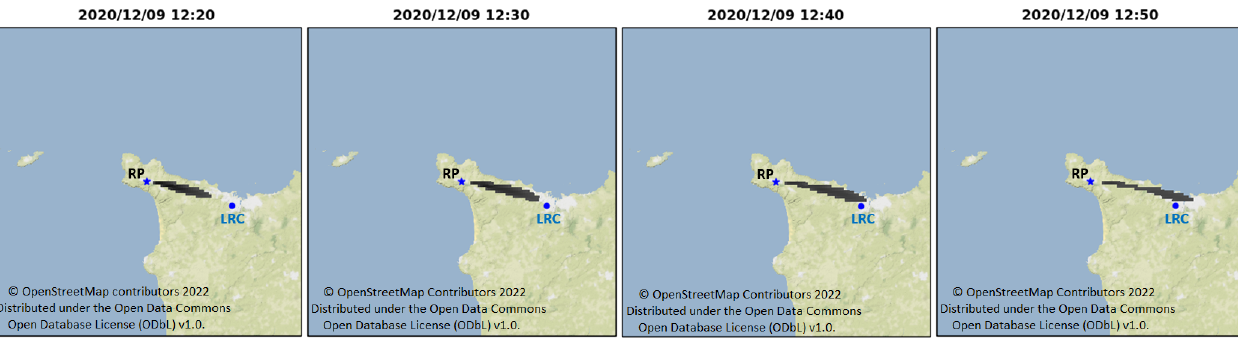
Figure 11. Simulation of the dispersion of the 85 Kr exceeding 1545Bqm − 3 in the case of member 1 presented in Fig. 9 and Table 4, surrounding the moment of the observed peak 3 at the LRC